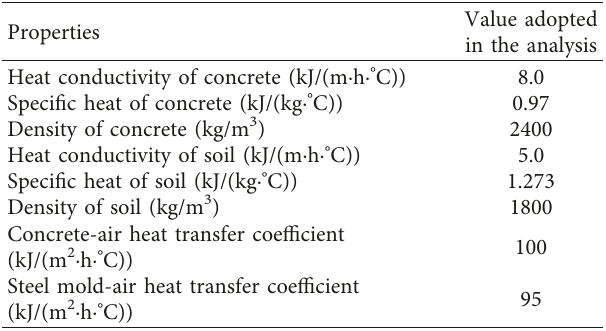
Table 2: Main thermal